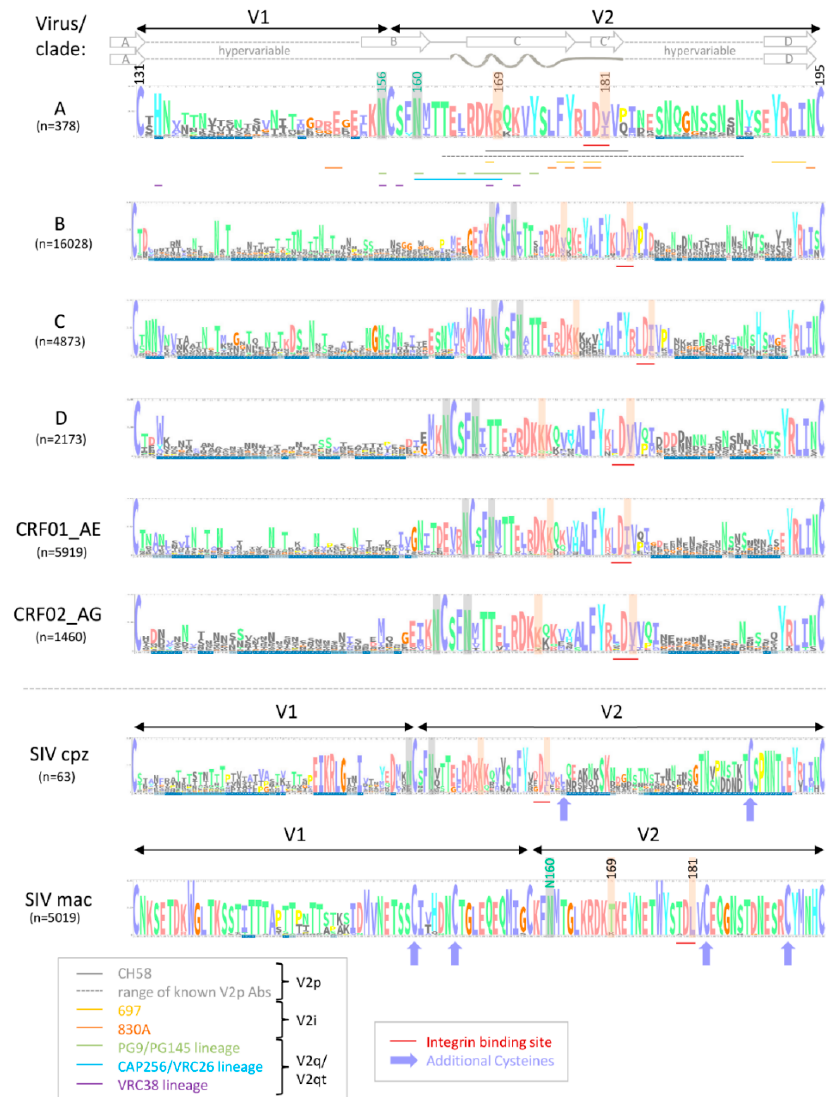
Figure 2. Comparative V1V2 sequence and epitope analysis across major HIV-1 group M clades and SIV. Sequence logo analyses are shown for the six most prevalent HIV-1 group M subtypes and circulating recombinant forms (CRF) in comparison to SIV from chimpanzees (cpz) and macaques (mac). Sequence logos were performed using the Skylign tool (skylign.org) with alignments using all functional aa sequences per virus/clade, downloaded from the LANL Sequence Database. The number of sequences used per logo is shown in parenthesis on the left (n). V1 and V2 loops, their hypervariable regions, and the β -barrel (top; native closed Env; β -strands labeled with A, B, C, C’, and D) versus α -helical conformation (bottom; open Env) are indicated by the schematic at top. The integrin binding site and V1V2 Ab epitopes are indicated with colored lines below the sequence logos according to the box on the lower left. The full set of epitopes is shown for HIV-1 subtype A representatively. Additional cysteines in SIV are highlighted with purple arrows. A dark blue field below the stack of aa indicates occupancy <75% for the respective site. Sites with <5% occupancy were removed from the sequence logos for better clarity. Functionally important aa positions are highlighted: asparagines of the potential N-glycosylation sites N156 and N160 are labeled in green and highlighted with a gray background; sites of immune pressure in RV144 [7], i.e., positions 169 and 181, are labeled and highlighted with an orange background. Epitope and structural regions are indicated according to reference papers and the LANL Immunology Database (Section 2) [22,46,47].